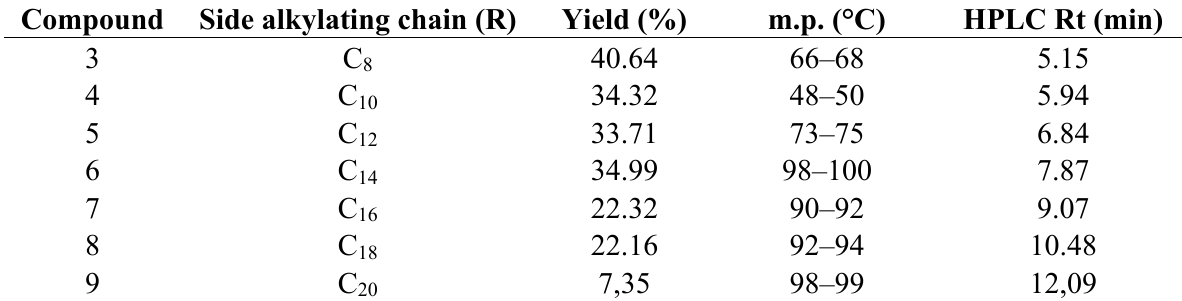
Table 1. Yields, melting points and retention times of prepared quinolinium salts.